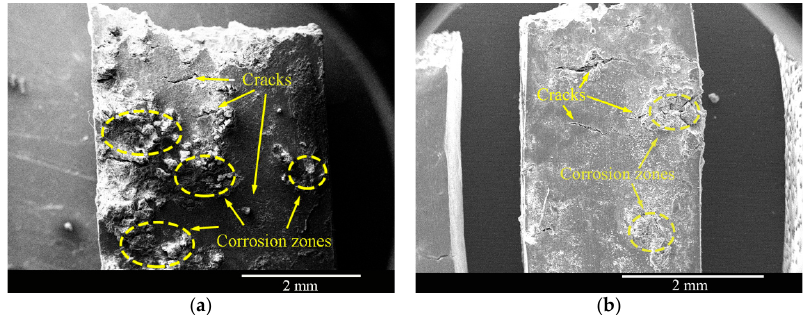
Figure 8. Top-surface morphologies of the ( a ) as-cast and ( b ) solid-solution-treated AM50 magne- sium alloy samples corrosion SSRT tested in 3.5% NaCl solution.